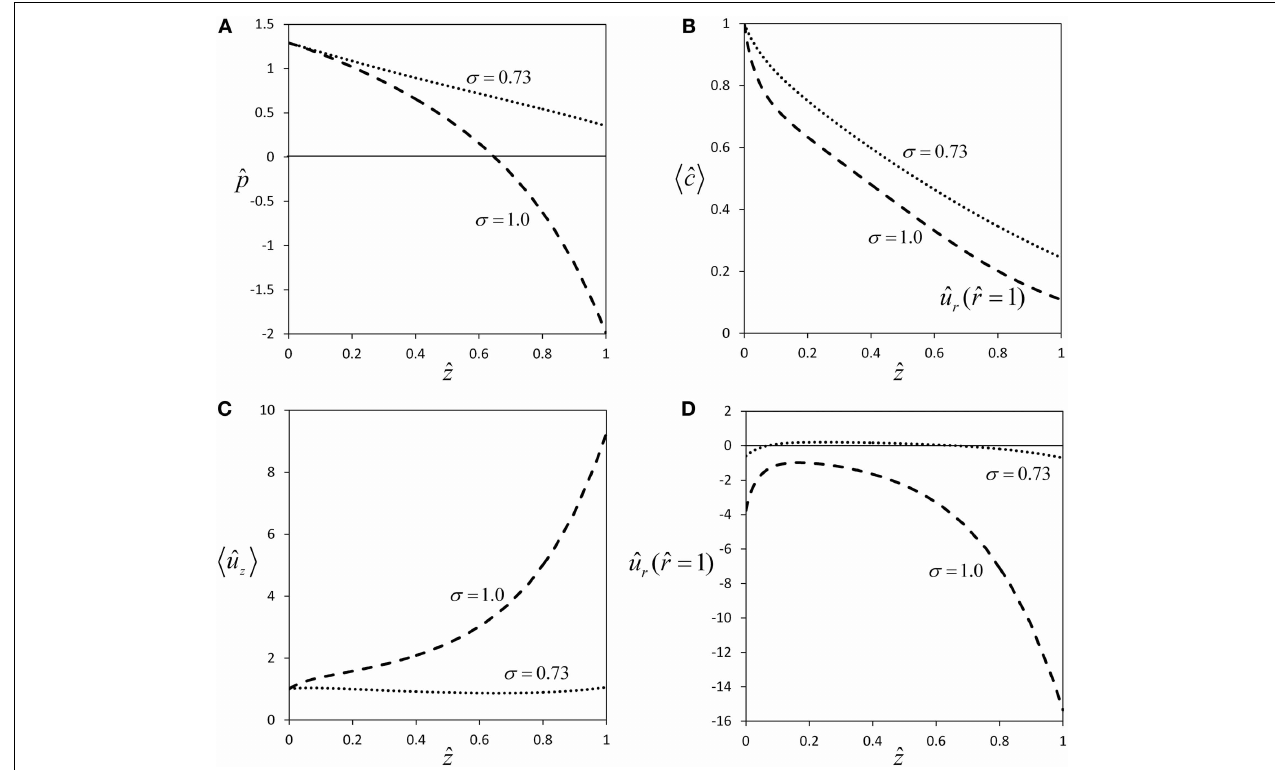
FIGURE 5 | Effect of membrane solute permeability on flow within long sieve tubes. Profiles of pressure (A) , average concentration (B) , average axial velocity (C) and radial velocity at sieve tube membrane (D) for same parameter